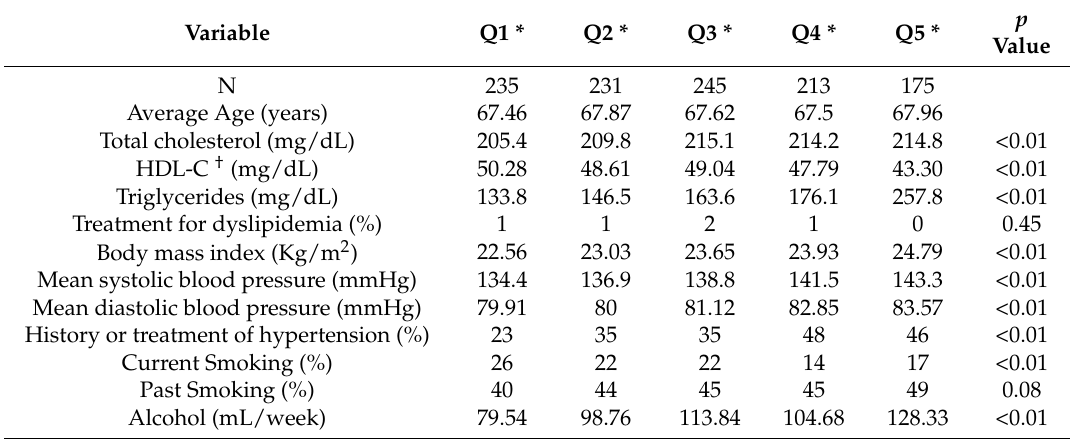
Table 1. Baseline characteristics by glucose quintiles.